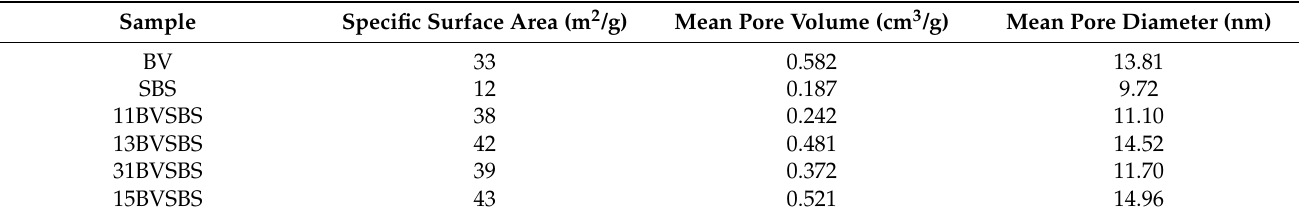
Table 1. The surface area characteristics of the BVSBS